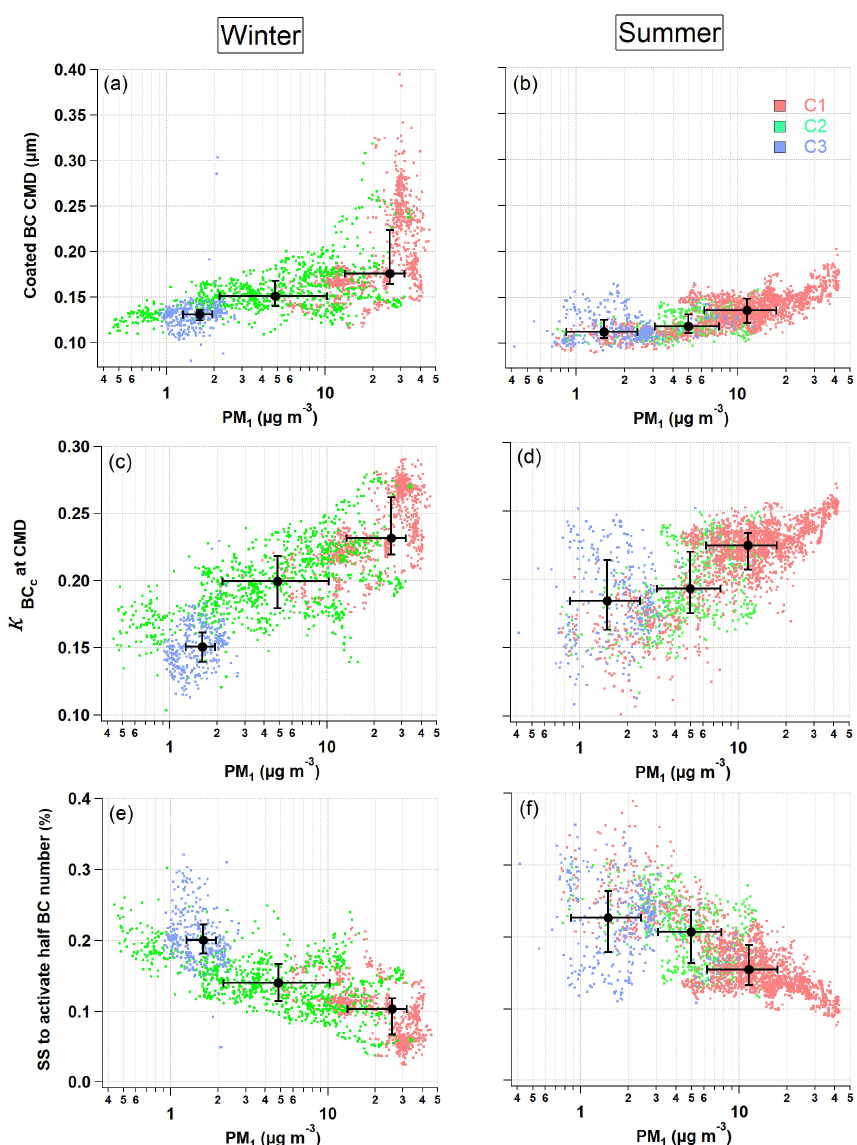
Figure 7. Hygroscopic properties of BC for the three PBL types in both seasons. Panels (a) and (b) are the count median diameter of coated BC; panels (c) and (d) are the κ BCc assuming κ coating = 0.3; panels (e) and (f) are the supersaturation (SS) to activate half of the BC number population. In each panel, the solid circles and whiskers denote the median and 25th and 75th percentiles,